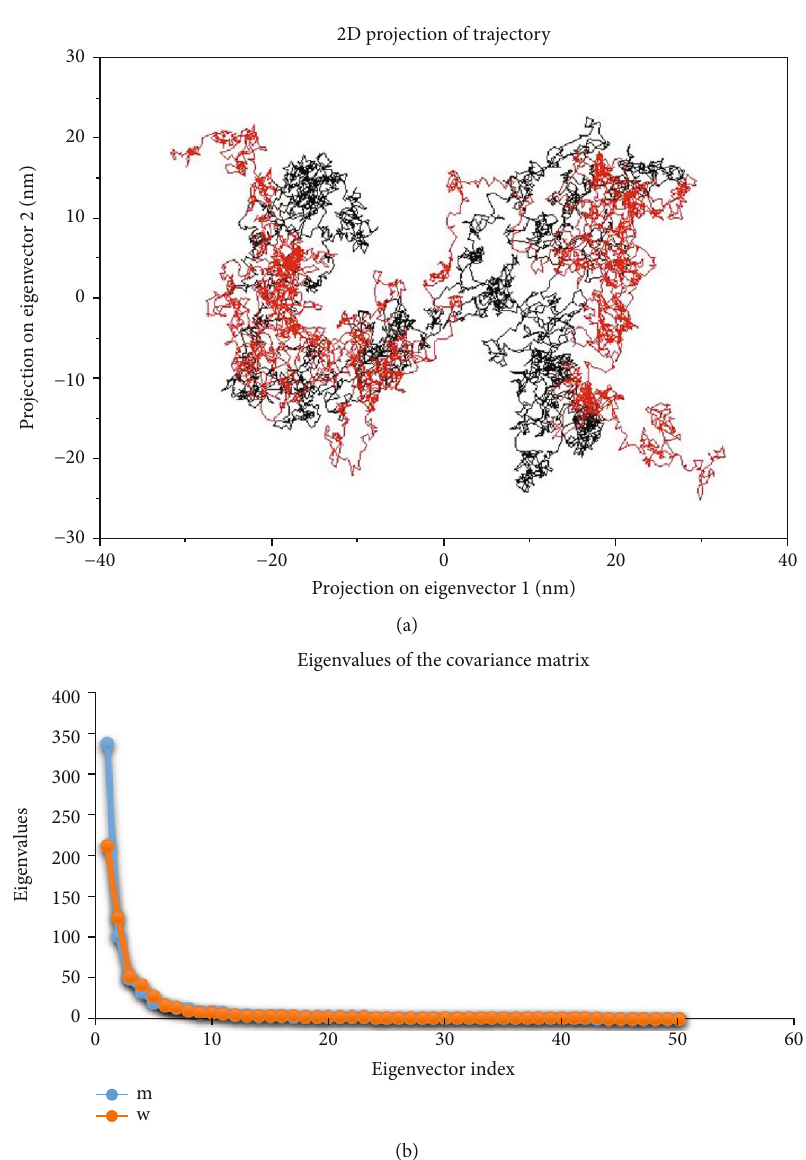
Figure 5: Principal component analysis. (a) Projection of the motion for wild-type (black) and mutant (red) in phase space along the PC1 and PC2; (b) eigenvalues vs. eigenvector index plot were plotted for the fi rst 50 eigenvector, wild type (red), and mutant